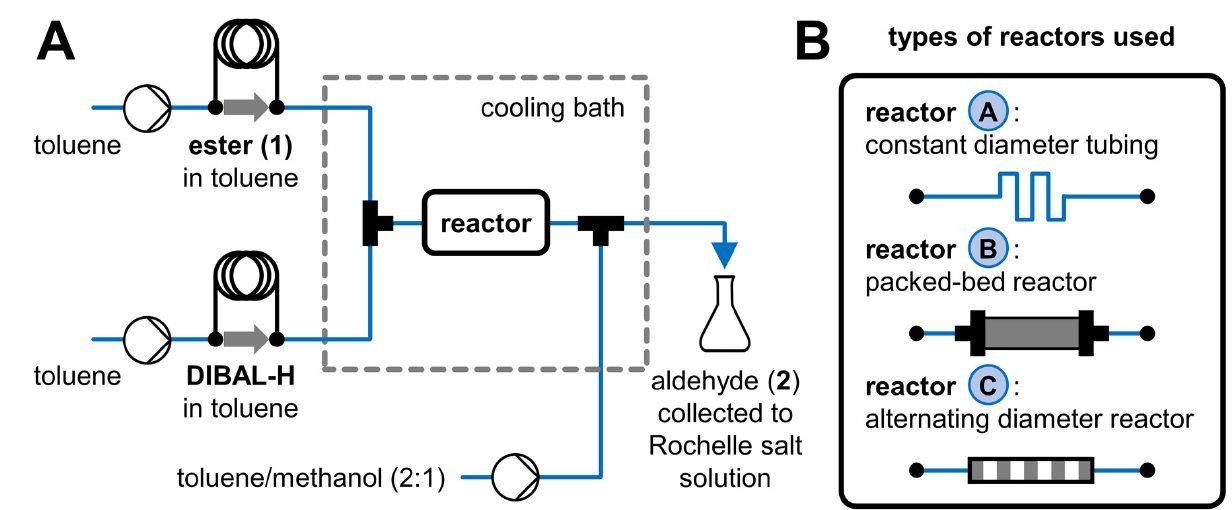
Figure 1. Schematic representation of the continuous-flow ester reduction module. Different temperatures, residence times, and reactor volumes were screened in this setup (Table 1). At 0 ◦ C, conversion was low, and byproducts (mainly over-reduction to the alcohol) were formed in significant quantities (Entries 1–4). After decreasing the